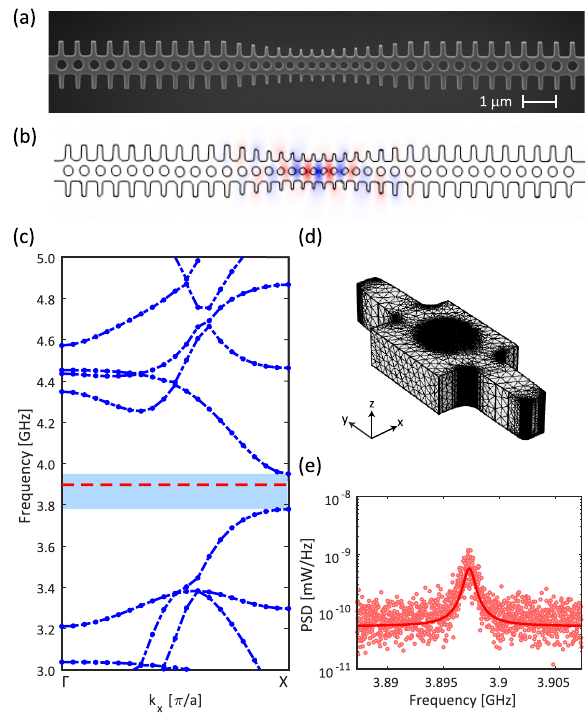
Figure 2: Optical and mechanical properties of the fabricated optomechanical (OM)